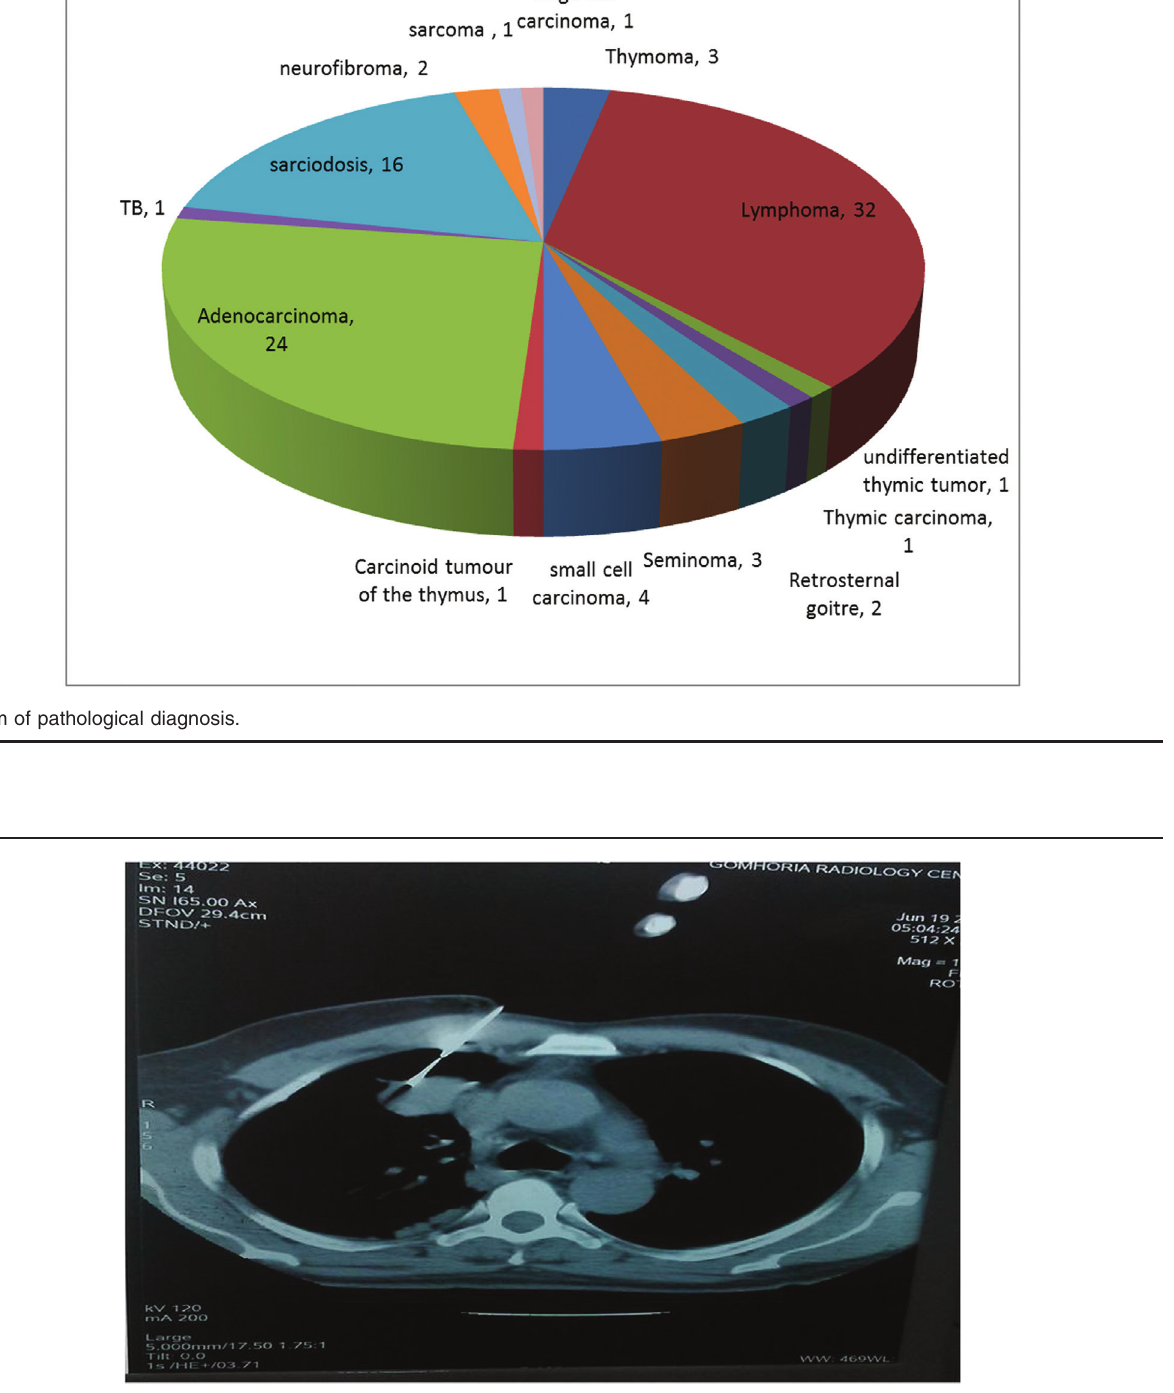
Fifty-four-year-old man diagnosed by CT-guided trucut biopsy (small cell carcinoma). CT, computed